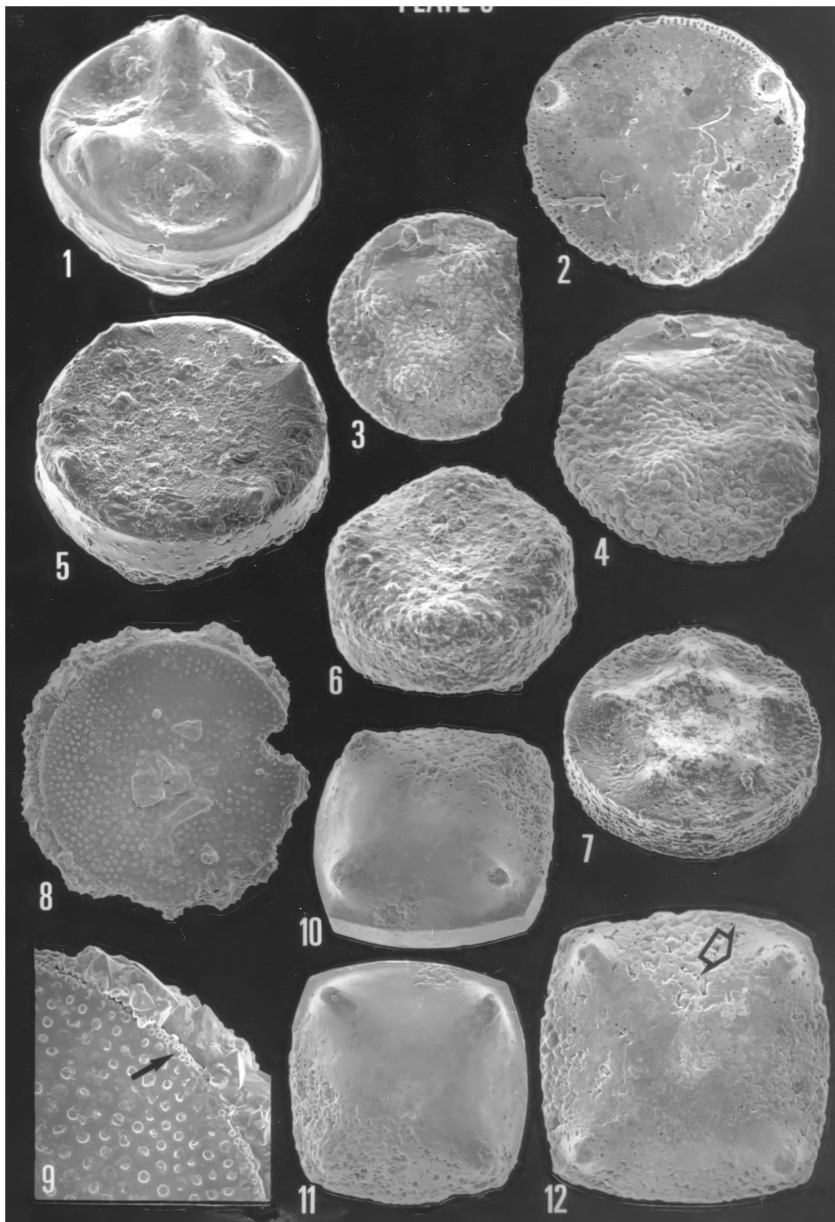
Plate 4. Aulacodiscaceae. NB all specimens pyritised. (1) Aulacodiscus subexcavatus Hustedt, (AGM 129) diameter 160µm. Oblique valve view. BP well 208/15a-1, 1220m (core), lower Eocene. (2) Aulacodiscus heterostictus Barker and Meakin, (AGM 130) diameter 150µm. Valve view. BP well 16/16a-3, 1322.7m (core), mid Eocene. (3–4) Aulacodiscus allorgei Chenevière. (3) (AGM 131) diameter 180µm. Valve view. BP well 3/25-1, 2162m (core), lower Oligocene. (4) Oblique valve view of (3) . (5–6, 10–12) Aulacodiscus insignis Hustedt. (5–6) Morphotype “aemulans”. (5) (AGM 132) diameter 250µm. Oblique valve view. BP well 16/16a-3, 1322.7m (core), upper Oligocene. (6) (AGM 133) diameter 130µm. Oblique valve view. BP well 15/28a-3, 3580’, lower mid Miocene. (7) Aulacodiscus singiliewskyanus Barker and Meakin. (AGM 134) diameter 260µm. Oblique valve view. BP well 208/15-1, 1315m (SWC), middle Eocene. (8–9) Aulacodiscus suspectus Schmidt. (8) (AGM 135) diameter 140µm. Valve view. Note raised, pustular areolae on valve face. BP well 21/9-1, 2122m, uppermost Palaeocene. (9) Detail of (8) . Width of view 40µm. Note smaller areolae at valve margin (arrow). (10–12) Aulacodiscus insignis Hustedt. (10–12) Morphotype “quadrata”. (10) (AGM 136) diameter 180µm. Oblique valve view. BP well 21/296-7, 5280’, lower Oligocene. (11) Valve view of (10) . (12) (AGM 137) diameter 225µm. Valve view. Note hexagonal areolae (arrow). BP well 21/10-1, 5060’, lower